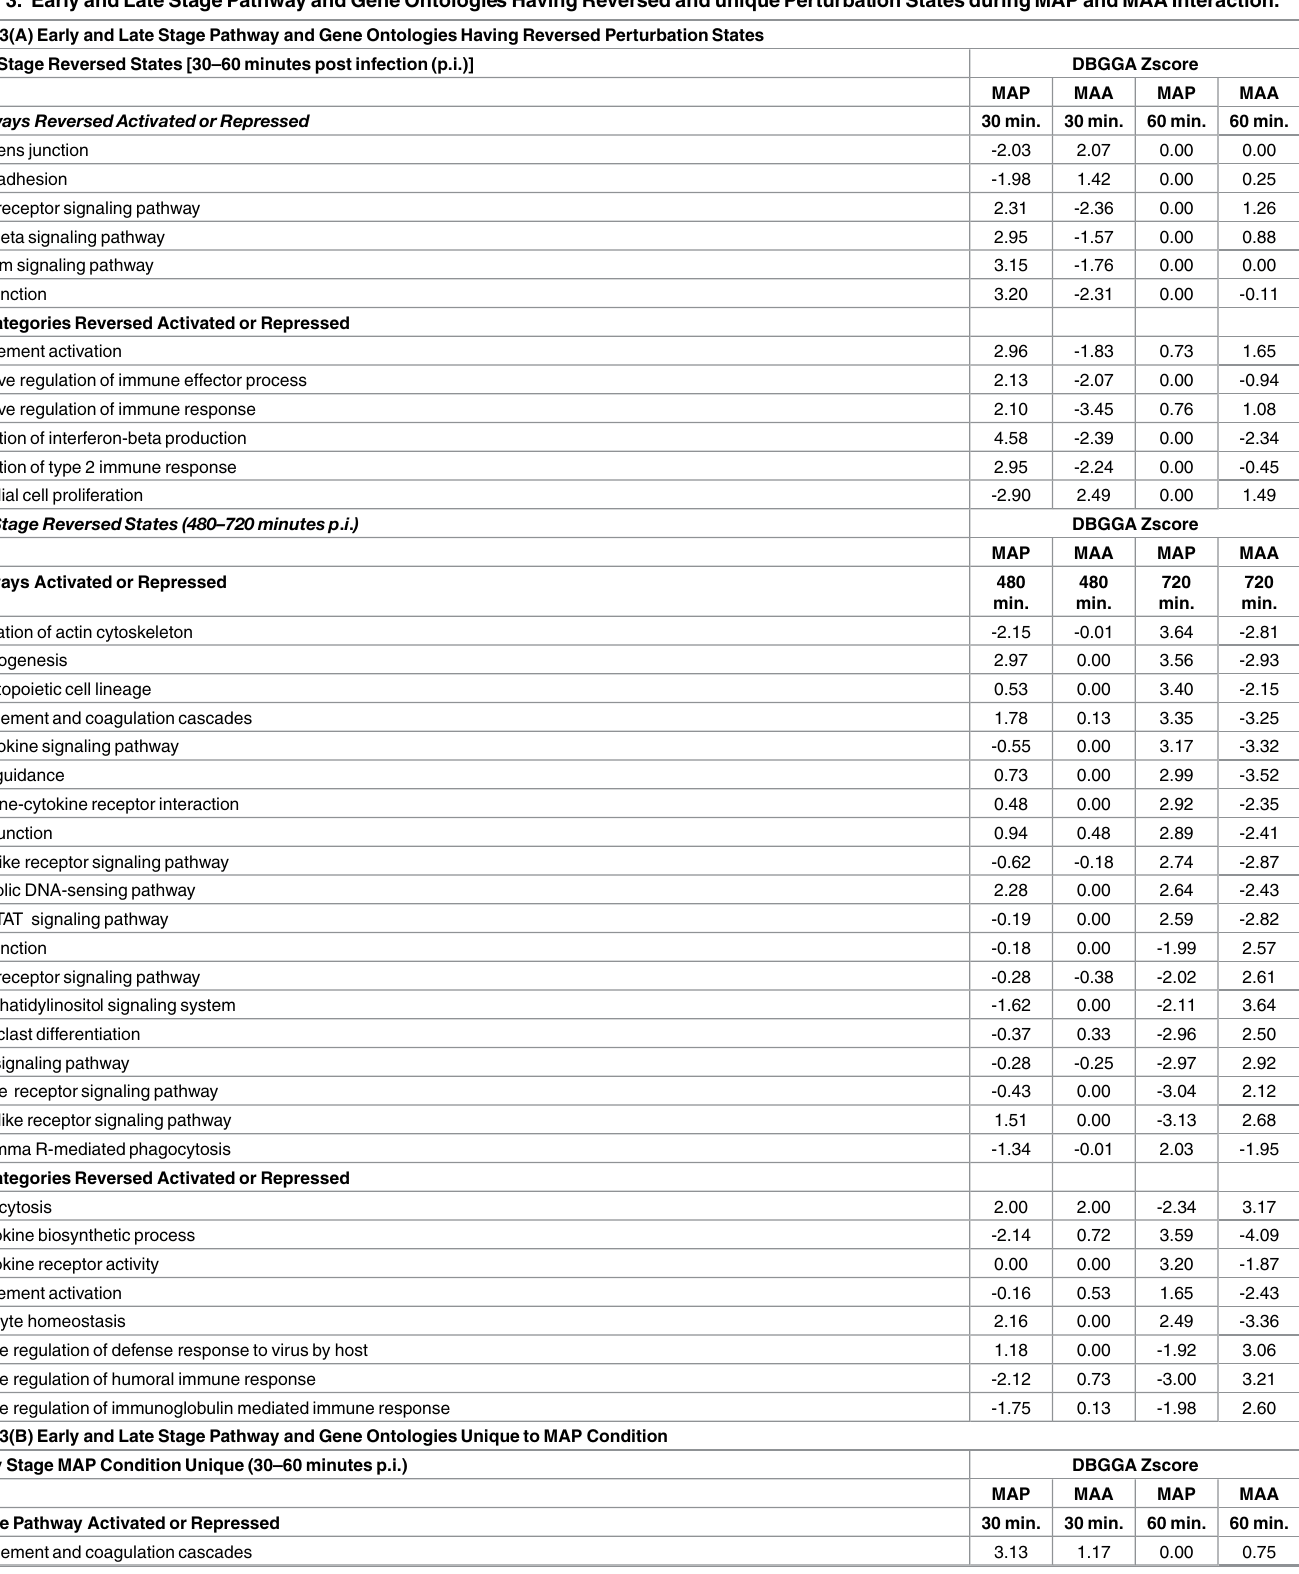
Table 3. Early and Late Stage Pathway and Gene Ontologies Having Reversed and uniquePerturbation StatesduringMAP and MAA Interaction. Table 3(A)Early and LateStagePathway and GeneOntologiesHaving Reversed PerturbationStates